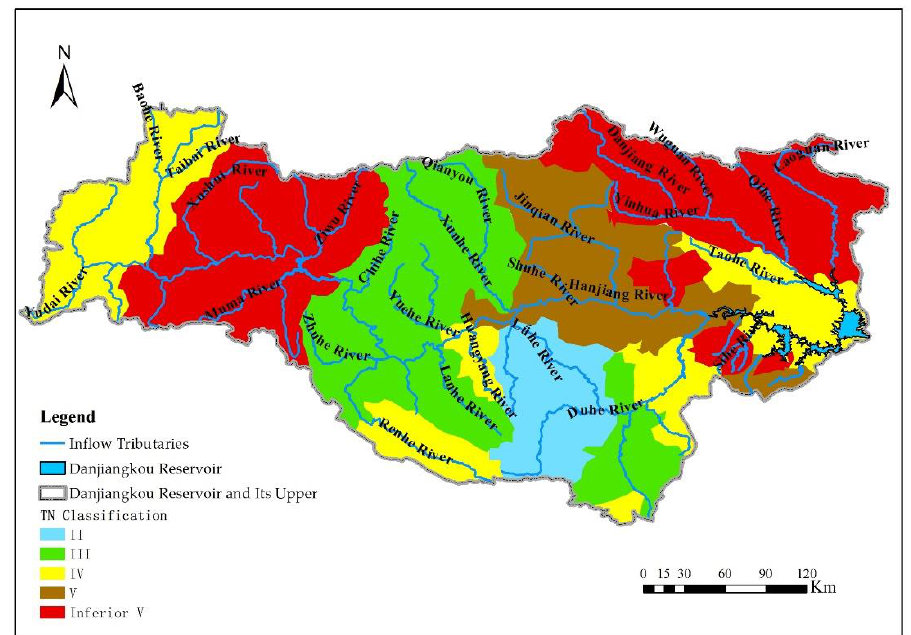
Figure 8. Distribution of total nitrogen concentration in Danjiangkou Reservoir and upper stream.